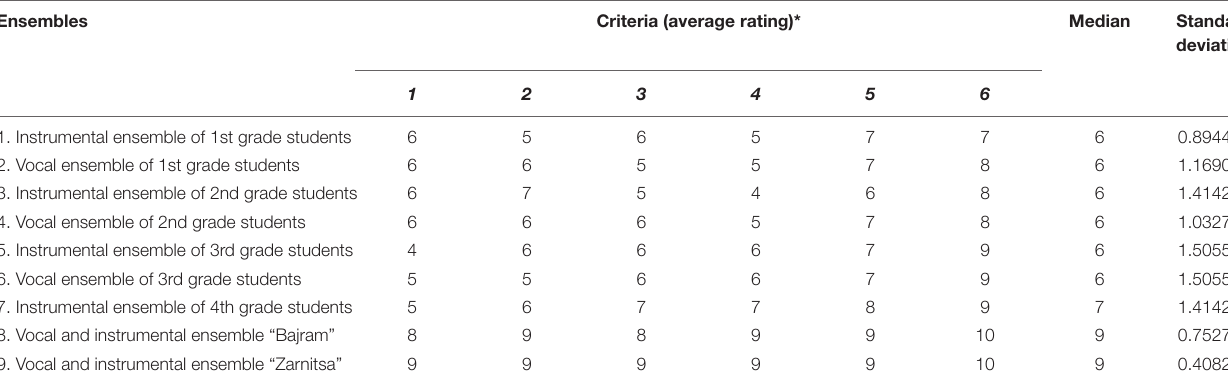
TABLE 4 | Video evaluation results.